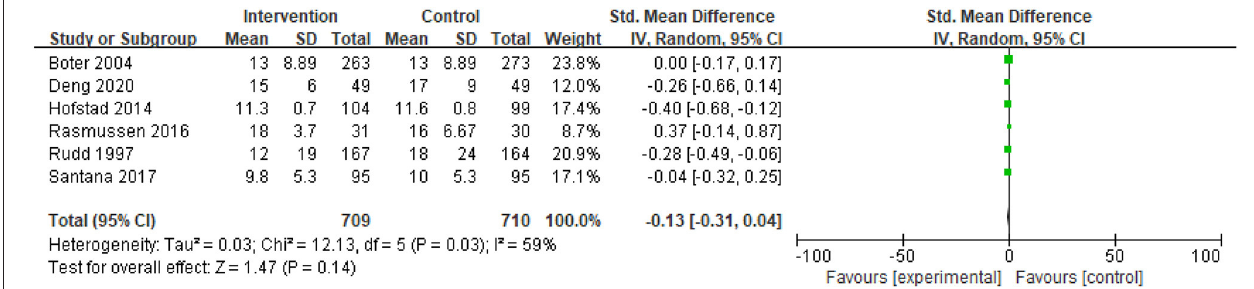
FIGURE 2 | Comparison ESD care vs. usual care; outcome I: length of hospital stay.